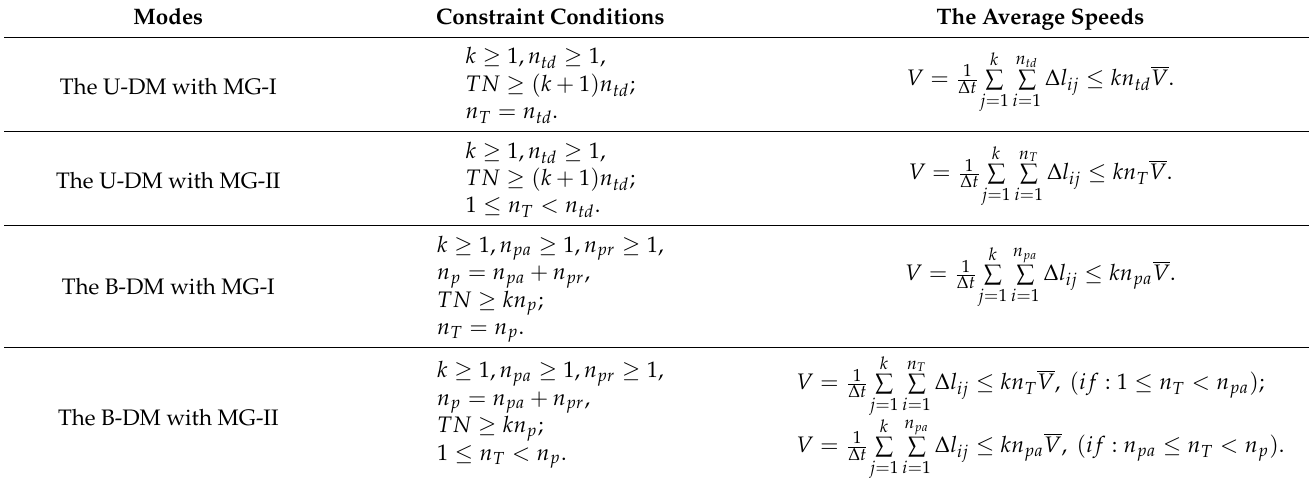
Table 1. The average speeds of the different locomotion modes of the earthworm-like robot. Modes Constraint Conditions The Average Speeds